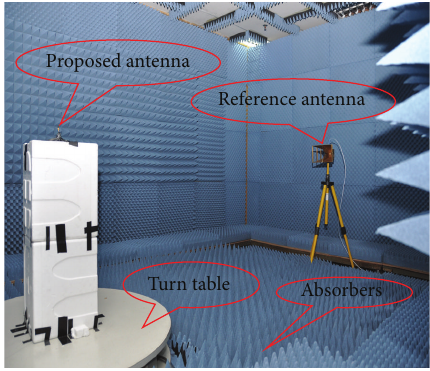
Figure 12: Illustration of the anechoic chamber for the proposed antenna.